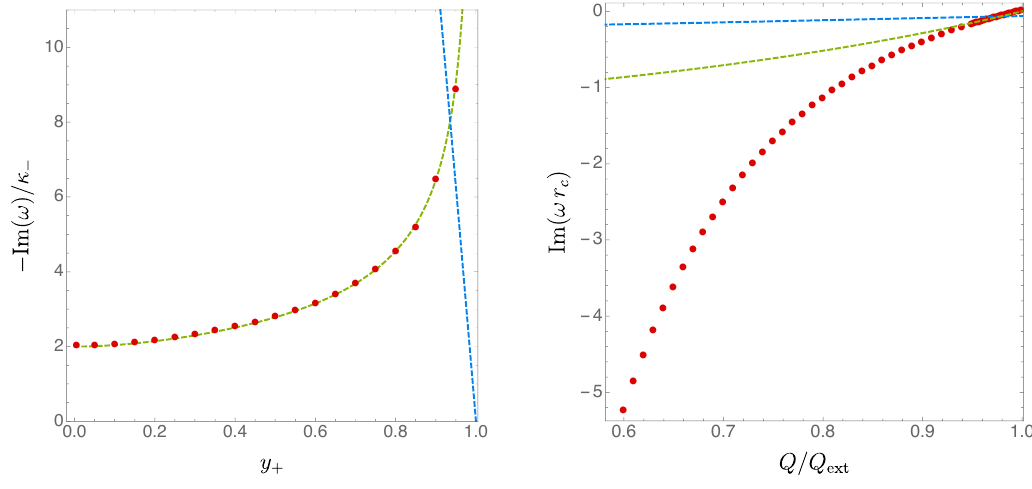
Figure 6 . Near-extremal modes for the gravitoelectromagnetic mode (cid:8) (cid:0) with ‘ = 2 and n = 0. In both plots, the dashed green line is the analytical prediction (5.26), or (5.25), and the red dots are our numerical results. Left panel: (cid:0) Im( ! ) =(cid:20) (cid:0) as a function of y + for near-extremal modes at (cid:12)xed Q=Q ext = 0 : 999. The dashed blue curve is the WKB prediction (5.11) for the photon sphere modes (also with Q=Q ext = 0 : 999). This WKB blue curve continues to increase monotonically as y + decreases. Right panel: Im( ! r c ) as a function of Q=Q ext for near-extremal modes at (cid:12)xed y + = 1 = 2. The dashed blue curve is again the WKB prediction (5.11) for the photon sphere